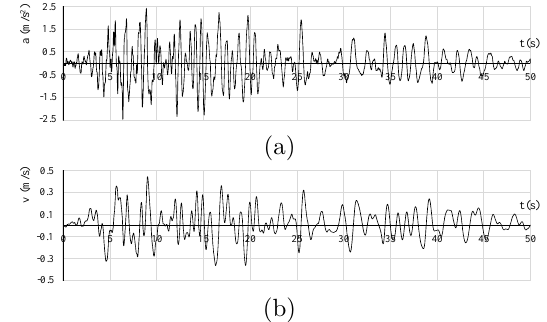
Figure 3. Adopted earthquake records: a) accelera- tion, b) velocity.